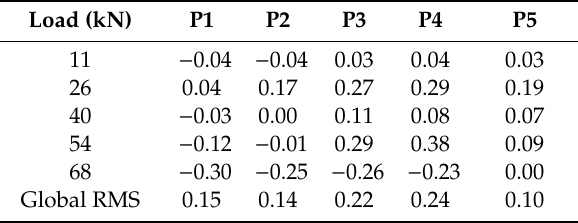
Table 4. DPA-LT (mm) beam#1 LC1.